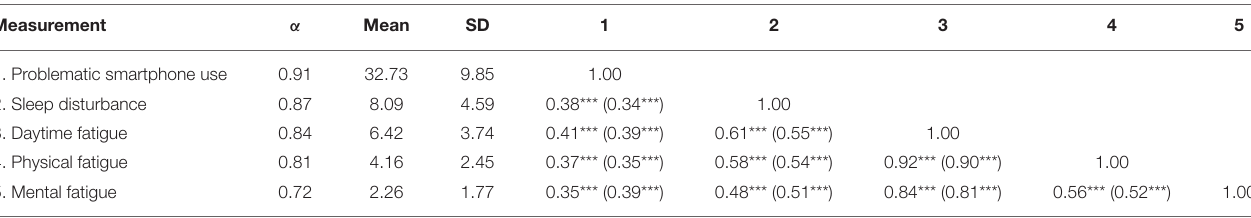
TABLE 2 | Correlation coefficients among SAS-SV, AIS, and FS